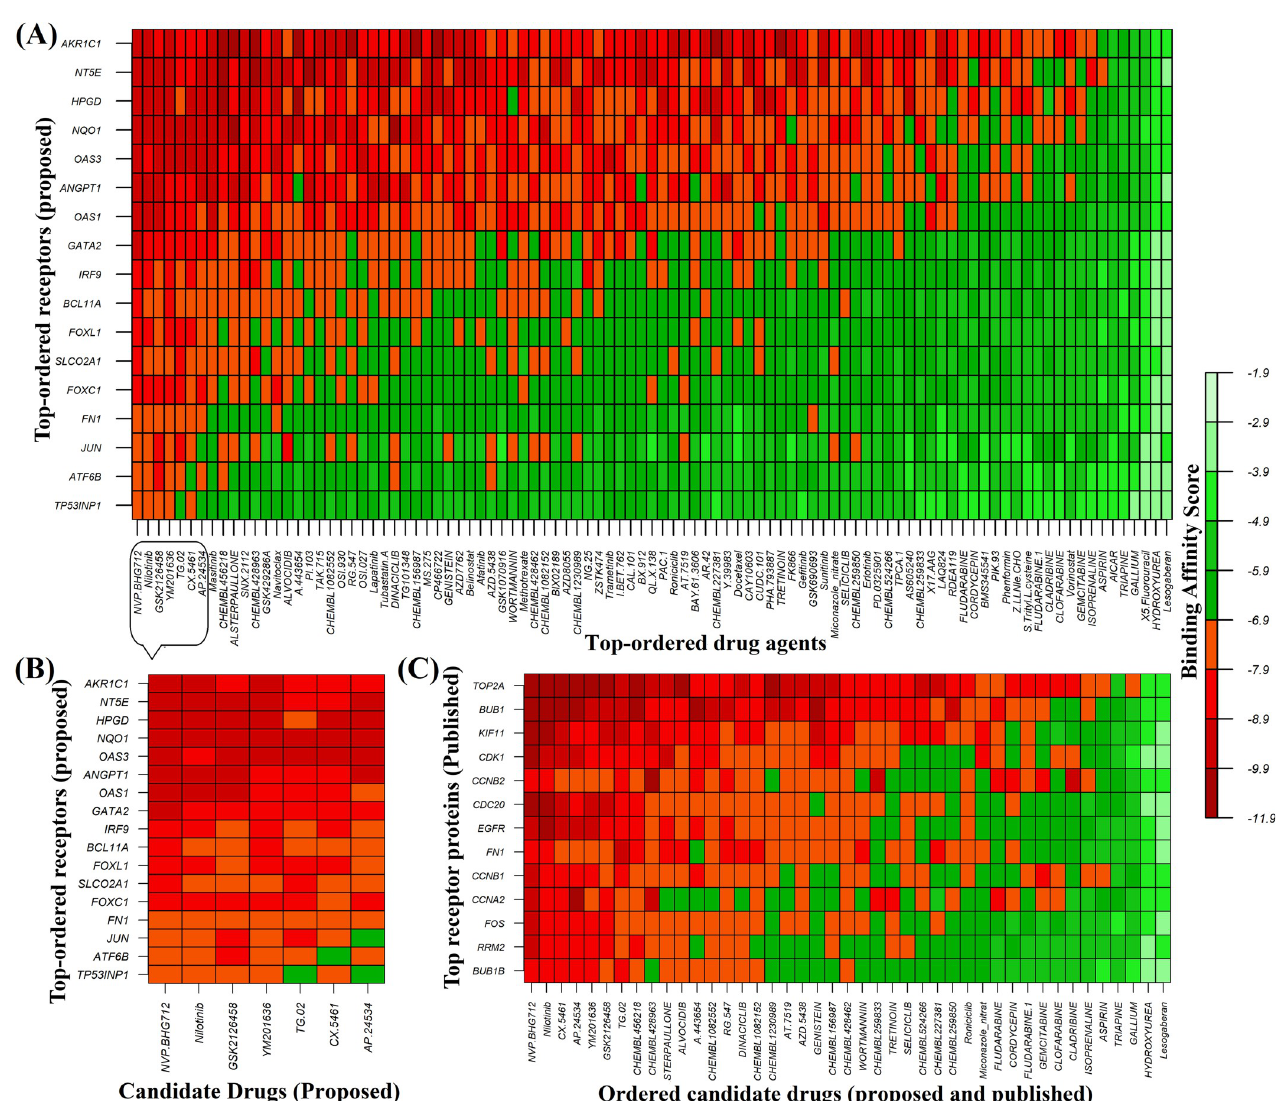
Fig 6. Molecular docking simulation results for exploring candidate drugs against BC. (A) Image of binding affinity scores of proposed ordered receptor proteins with the top 97 ordered meta-drug agents, (B) Image of binding affinity scores of proposed ordered receptor proteins with the proposed ordered candidate drugs only (C) Image of binding affinity scores of ordered proposed and already published candidate drugs against the top-ranked independent receptors published by others.